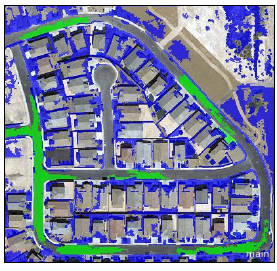
Figure 3. Object based classification result Highlighted in green are the road markers. The blue regions represent the background markers. All other regions are unmarked because they are unclassified.